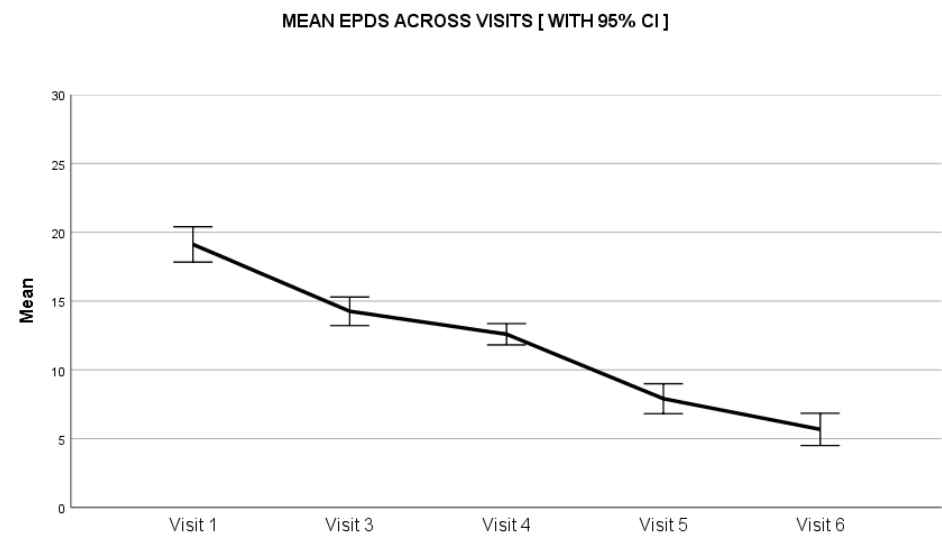
Figure 3. Impact of Lactobacillus reuteri DSM 17938 administration on analysis of maternal depression score. CI: Confidence Interval.